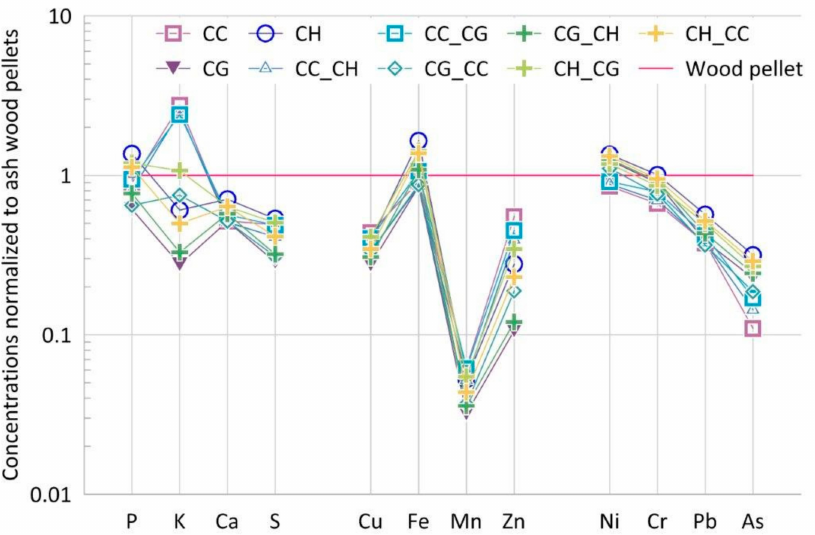
Figure 6. Average elements concentrations in the ashes of the materials tested standardized to their average content in ashes of wood